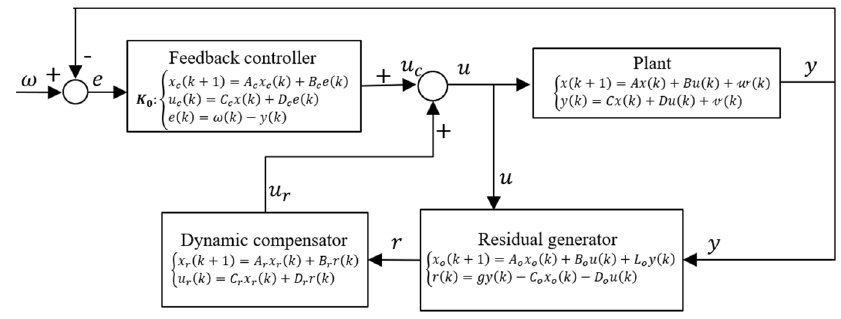
Figure 1. Structure of real-time monitoring and performance optimization.